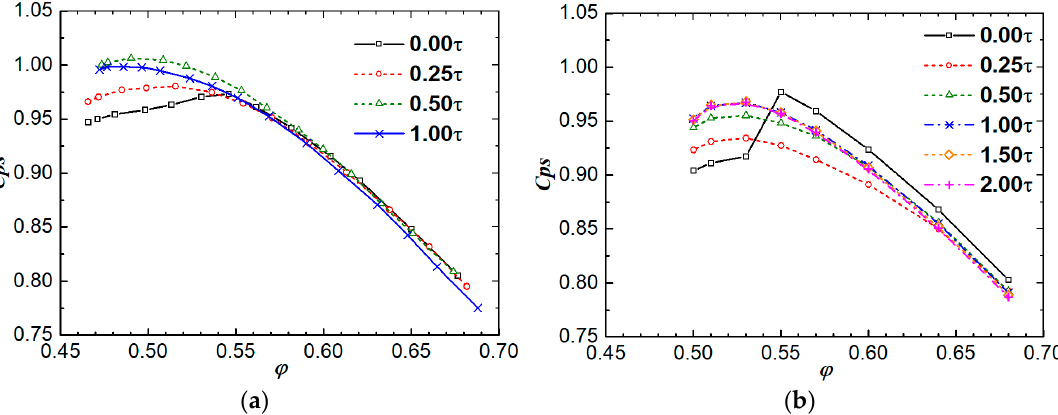
Figure 3. Characteristics of the compressor-stage static pressure-rise coefficient. ( a ) Experimental results; ( b ) CFD results.